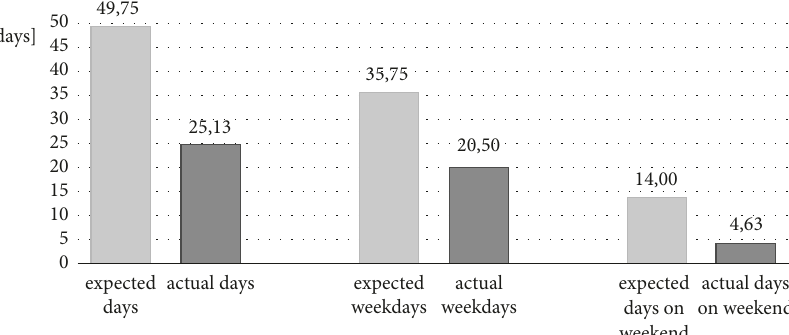
Figure 6: Descriptive analysis of expected and actual days worn in relation to all days, weekdays, and the weekends for MSS.